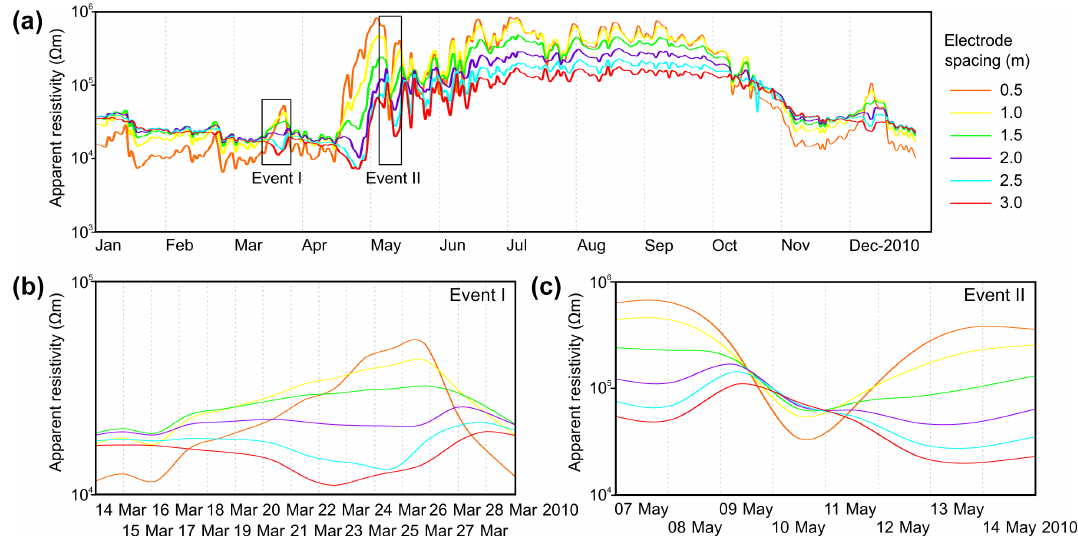
Figure 6. (a) Mean apparent-resistivity data of the A-ERT profile during 2010 for different electrode spacing on a daily scale. (b, c) Mean apparent-resistivity data on the scale of individual events: (b) brief surficial refreezing event from 14 to 28 March 2010 and (c) brief surficial thawing event from 7 to 14 May